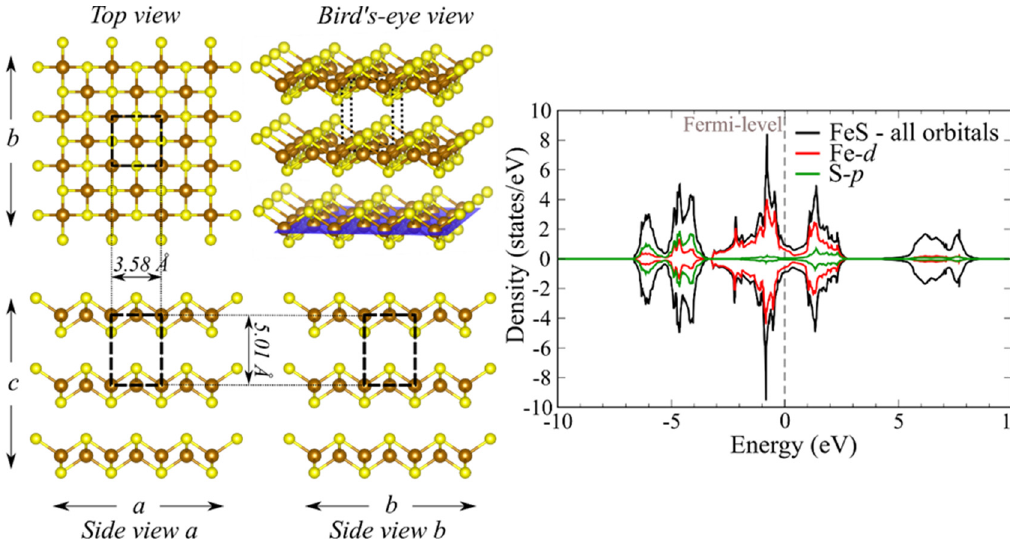
Figure 1. Crystal structure of bulk FeS mackinawite shown on the left. The unit cell is indicated with black striped lines, while sulphur and iron atoms are coloured yellow and brown, respectively. The total electronic densities of states, together with the orbital projected ones, are shown on the right.